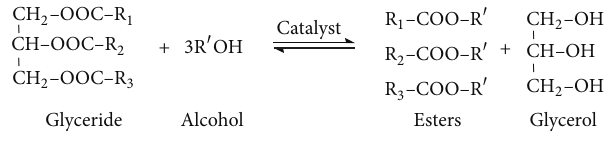
Figure 1: The chemical reaction of transesterification